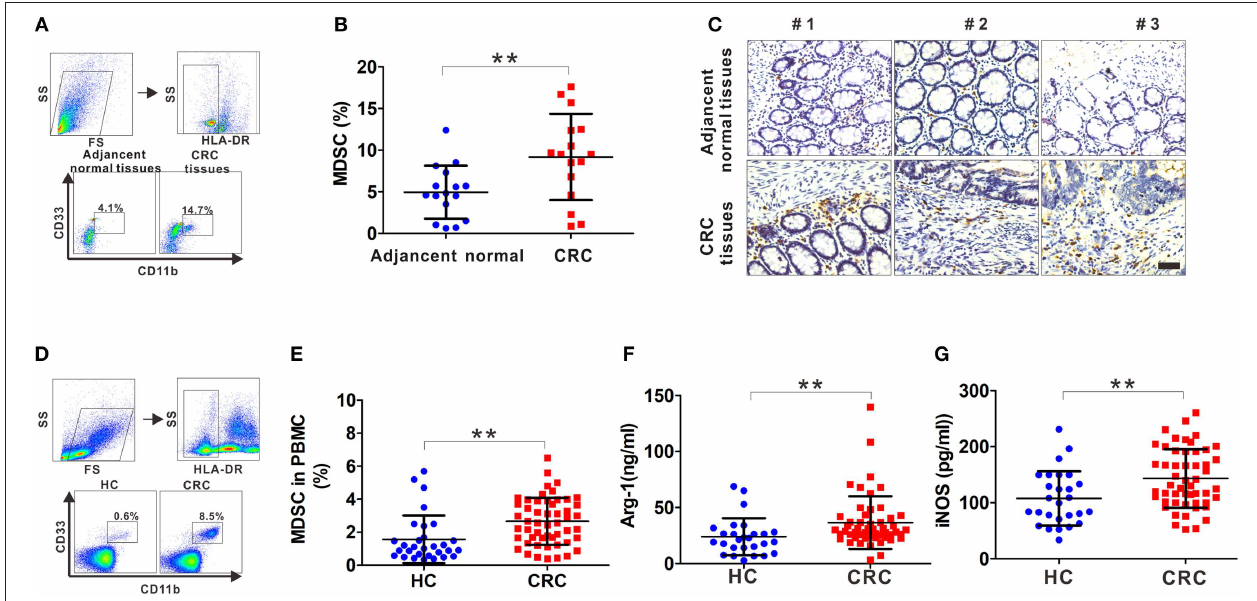
FIGURE 1 | The frequency of MDSCs in CRC patients. (A) The gating strategy for HLA-DR − CD33 + CD11b + cells from tissue samples of CRC patients. (B) Statistical analysis for the percentage of infiltrating MDSCs in 16 paired CRC samples including tumor tissues and adjacent normal tissues. (C) Representative IHC staining for CD33 in tumor tissues and adjacent normal tissues from three CRC patients. Blank scale bars = 100 µ m. (D) The gating strategy for HLA-DR − CD33 + CD11b + cells from the peripheral blood of CRC patients. (E) Statistical analysis for the percentage of circulatory MDSCs in PBMCs from healthy controls (HC, n = 30) and CRC patients ( n = 52) by FCM. (F–G) ELISA analysis of serum Arg1 and iNOS levels from HC ( n = 30) and CRC patients ( n = 52). Data represents the mean ± SD. ** p < 0.01.